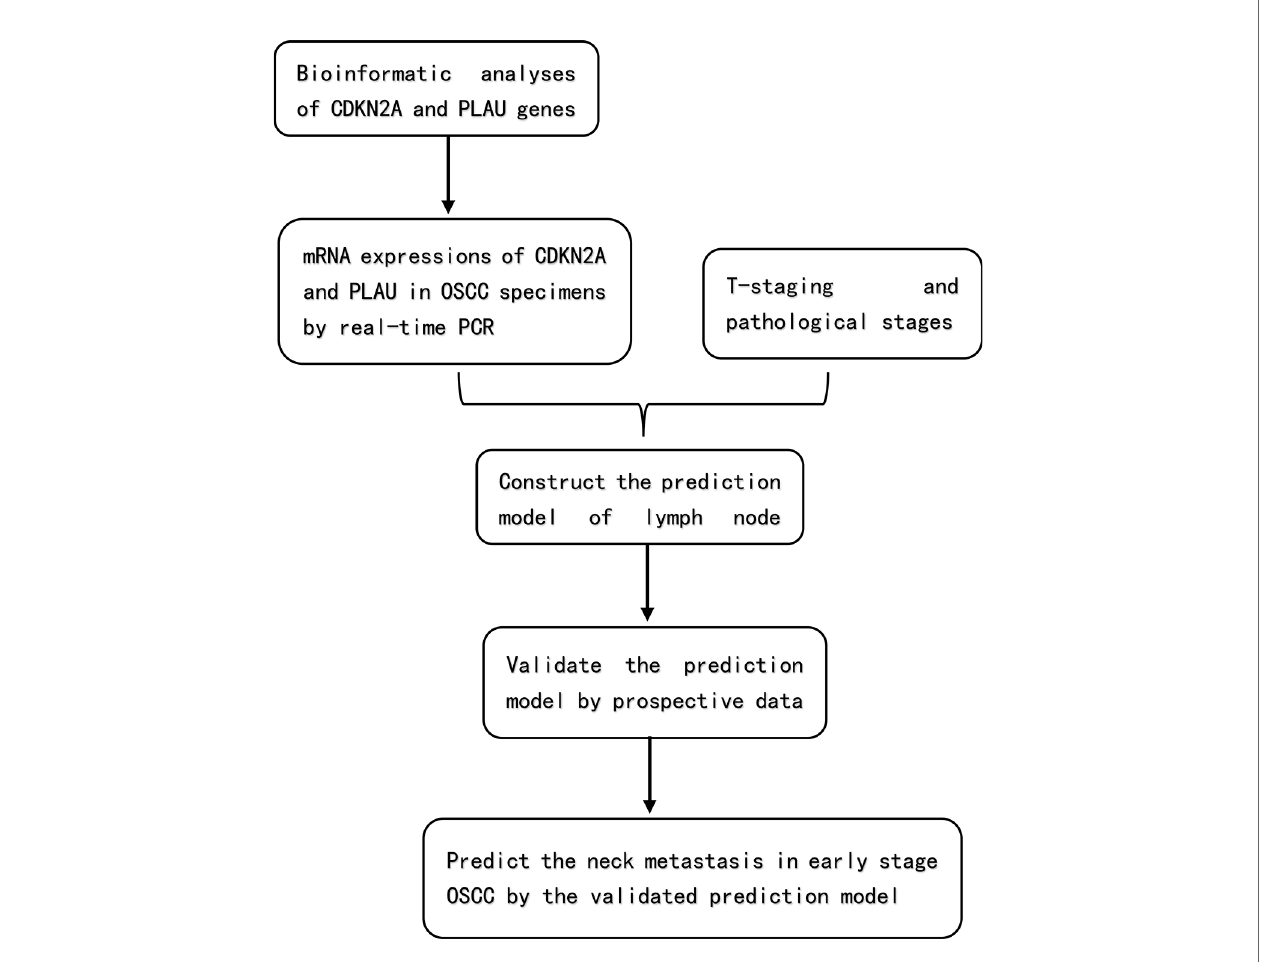
FIGURE 1 | The fl owchart of the